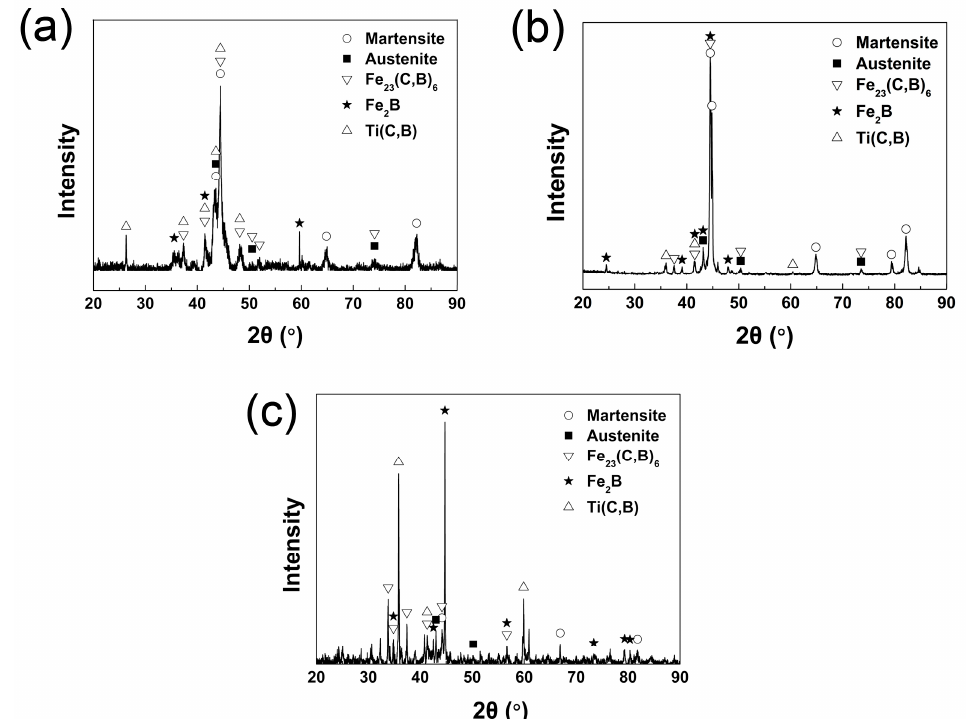
Figure 1. XRD spectra of various hardfacing layers with different of B additions: ( a ) 1.71%; ( b ) 5.10%; ( c ) 6.85%.